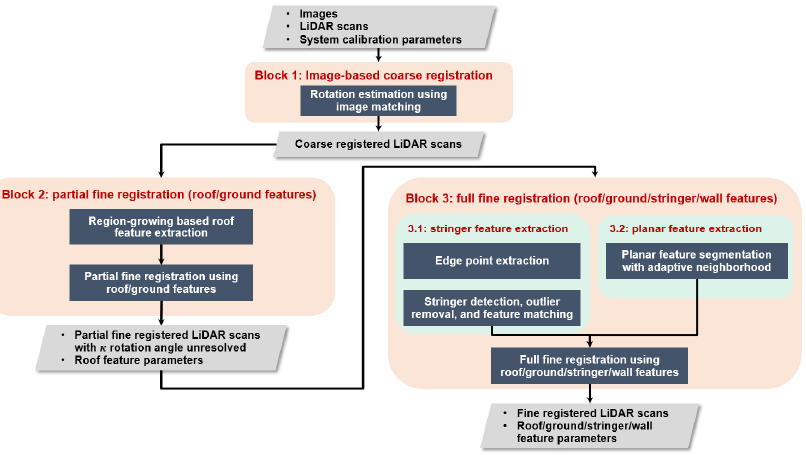
Figure 8. Proposed data processing framework for registration of SMART scans acquired in dome facilities.